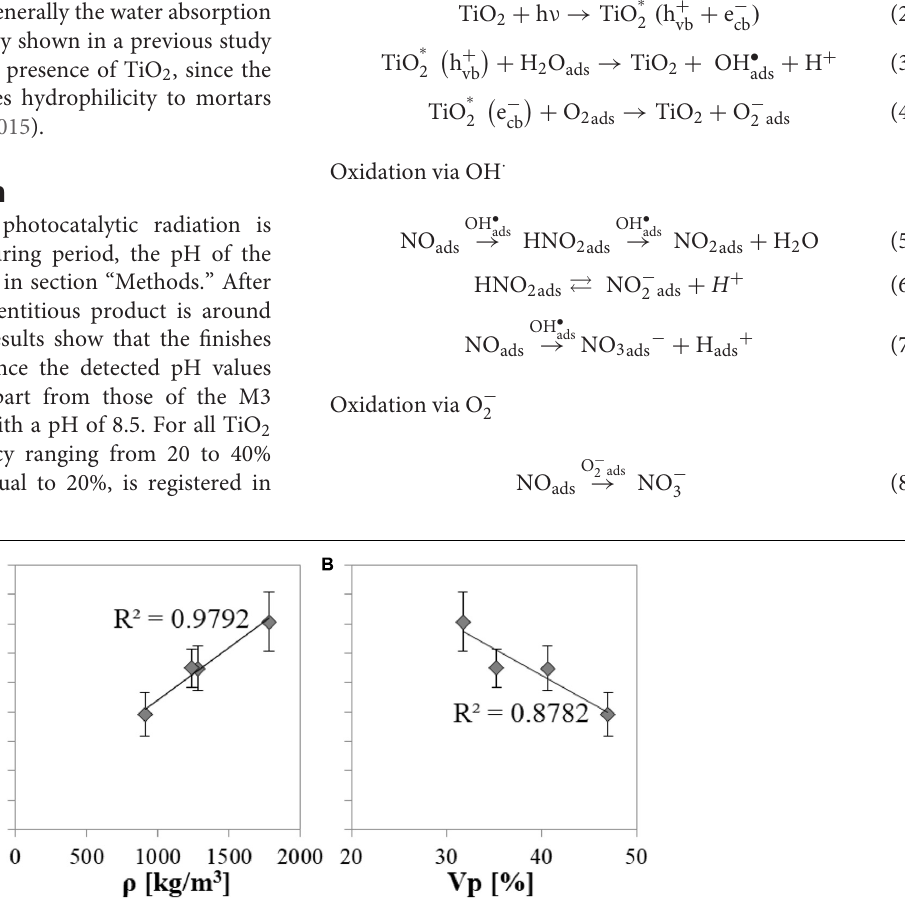
Frontiers in Materials |